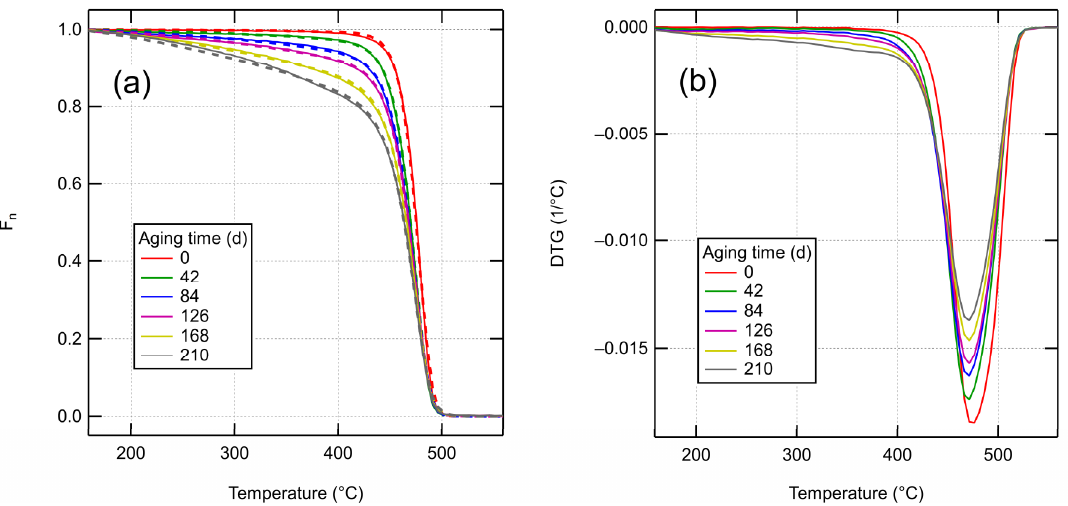
Figure 5. TGA curves. ( a ) Solid lines show experimental TGA curves, while dashed lines show the fitted model curves. ( b ) Differentiated experimental TGA curves. fitted model curves. ( b ) Differentiated experimental TGA